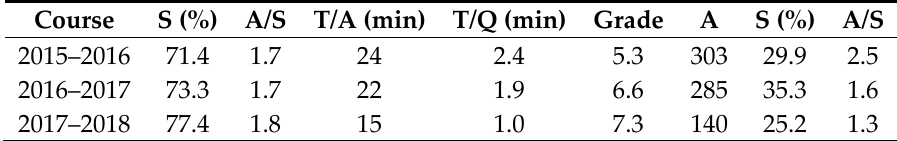
Table 1. Questionnaires for assessment (cols. 2–6): percentage of students (S), number of attempts